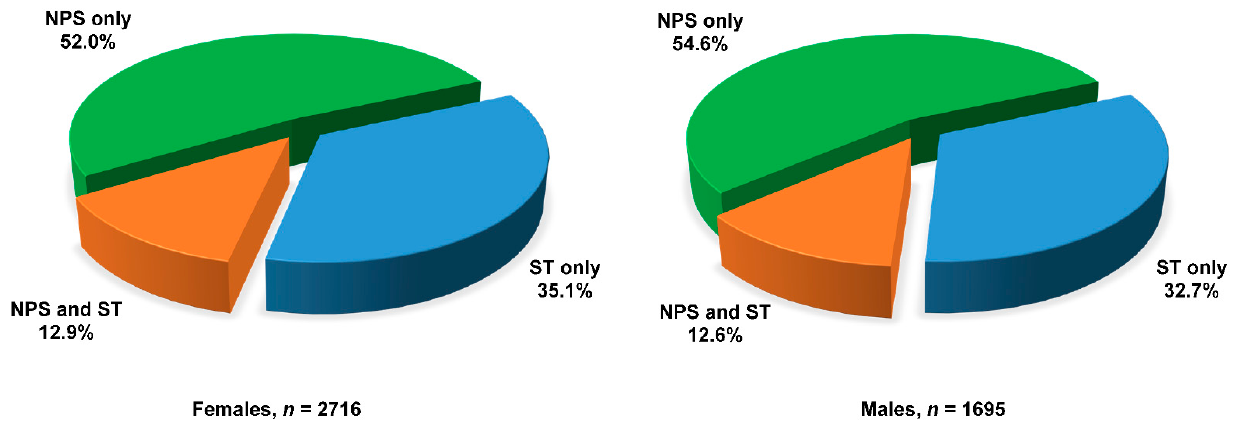
Figure 4. Distribution of positivity to SARS-CoV-2 by type of test performed in 4411 cases between March 2020 and February 2021 by sex. NPS: nasopharyngeal swab. ST: serological test.